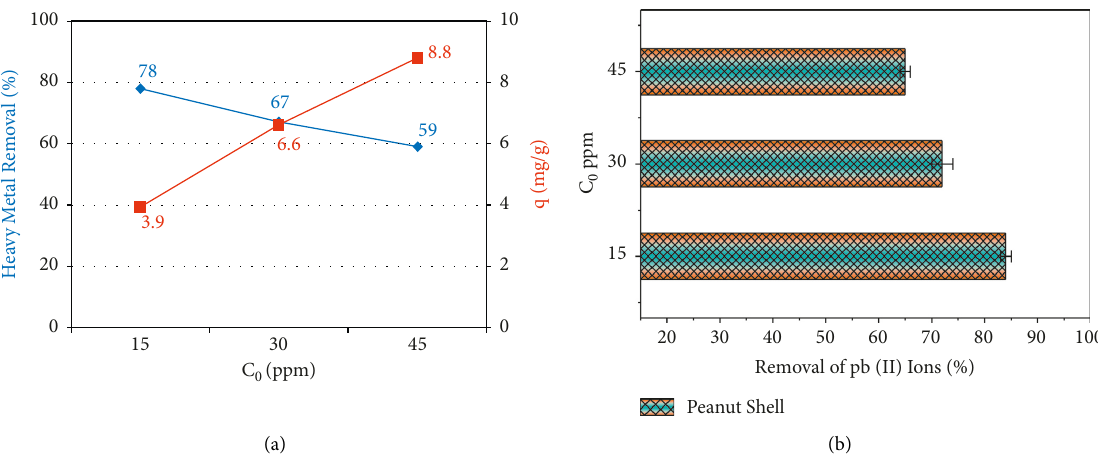
Figure 5: (a) Adsorption performance for varying Pb concentration. (b) Adsorption rate of peanut shell.